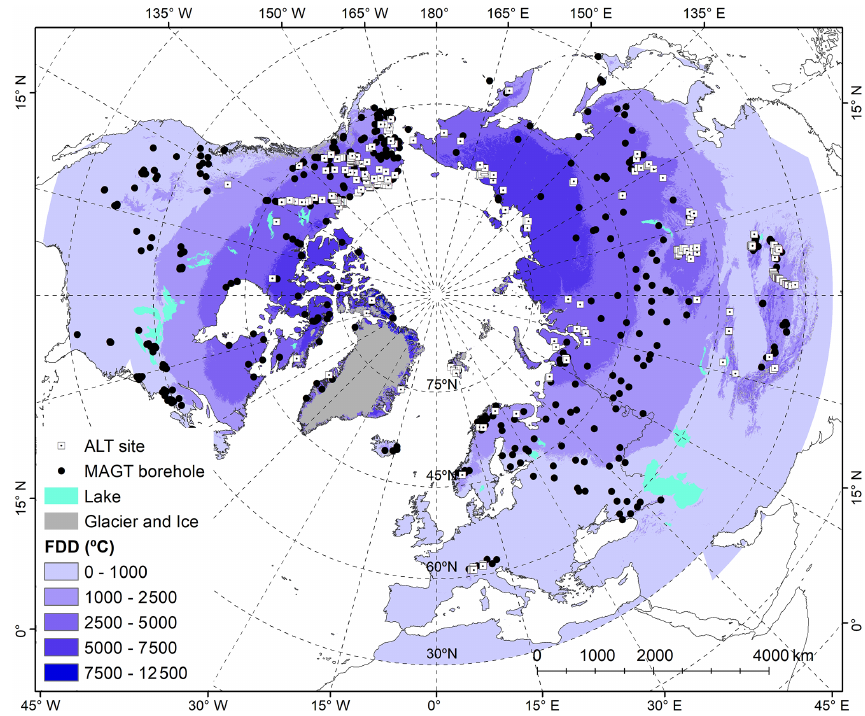
Figure 2. The distribution of the boreholes (1002) for monitoring the mean annual ground temperature (MAGT) and the sites (452) for monitoring the active layer thickness (ALT) used in this study. FDD refers to the freezing degree days ( ◦ C) derived from gap-filled daily MODIS land surface temperature. Table 1. Environmental and climate variable datasets used in this study to predict MAGT (mean annual ground temperature) and ALT (active layer thickness). MODIS, Moderate Resolution Imaging Spectroradiometer; LST, land surface temperature; AVHRR, Advanced Very High Resolution Radiometer; GLASS, Global Land Surface